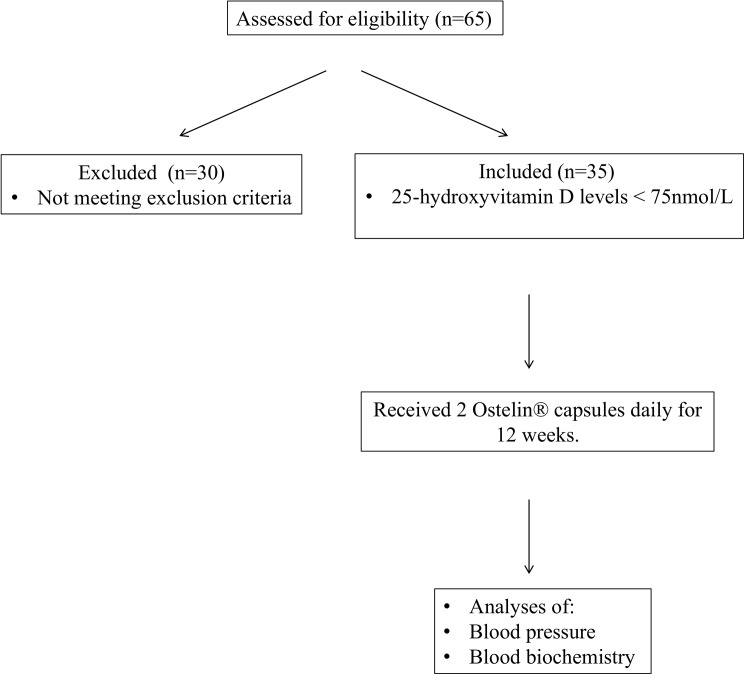
Study design diagram.